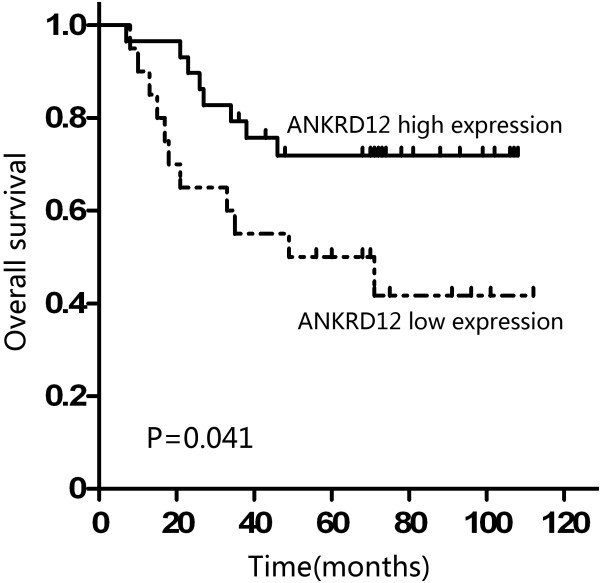
Kaplan-Meier survival curves of CRC patients without liver metastasis according to the status of ANKRD12 expression. Patients with low ANKRD12 mRNA expression showed significantly poorer prognosis than those with high ANKRD12 mRNA expression (P = 0.041, log-rank test).